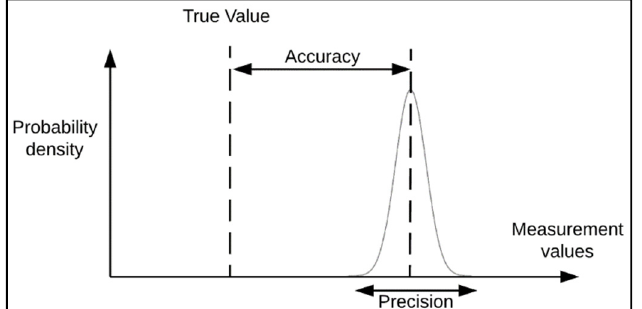
Figure 2. Accuracy–precision distinction. Illustration of the distinction between the concepts of accuracy (closeness of agreement between a measured value and a sought out true value) and precision (closeness of agreement between measured values obtained by replicate measurements on the same or similar objects under specified conditions) [62].